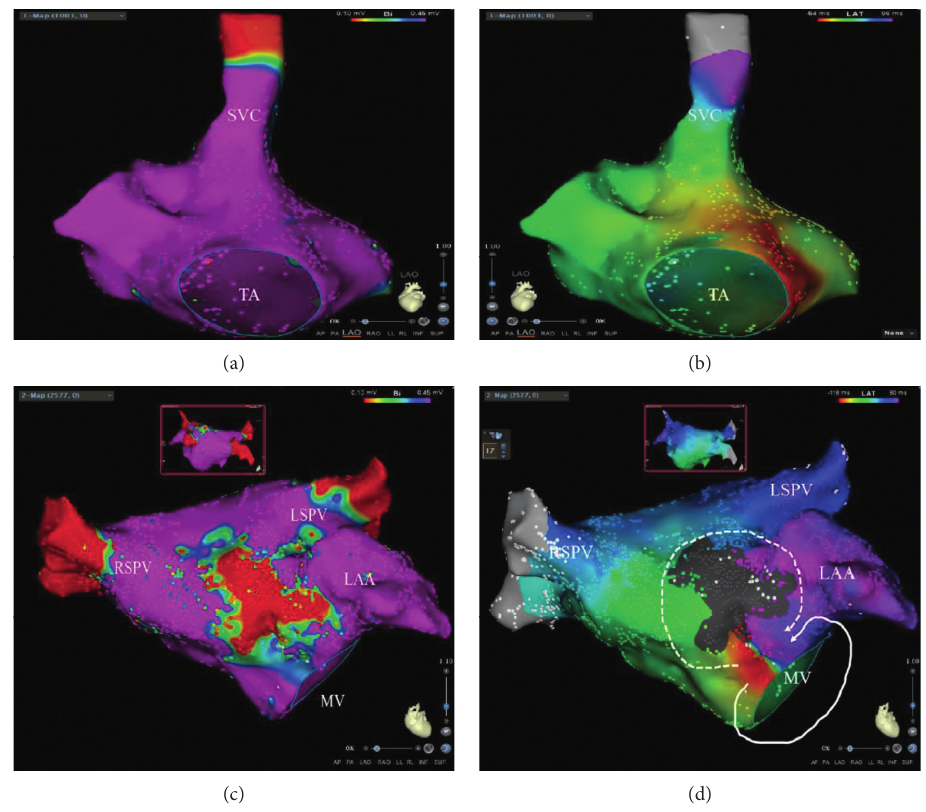
Figure 1: Left atrial macroreentry tachycardia promoted by anterior scar. (a) The low voltage areas were not found in RA. (b) A nonreentrant activation with the earliest site in the atrial septum and the total activation time in the RA < 90% of the TCL. (c) Bipolar voltage map of the left atrium in anterior-posterior and posterior-anterior wall (insets). A central scar was seen in left atrial anterior wall (LAAW). (d) Left atrial activation maps of the patients with a double-loop reentry, a counterclockwise loop around the mitral valve (white solid lines), and a clockwise loop (white dotted lines) around the scar of LAAW. SVC: superior vena cava; TA: tricuspid annulus; LAA: left atrial appendage; MV: mitral valve; RSPV: right superior pulmonary vein; LAAW: left atrial anterior